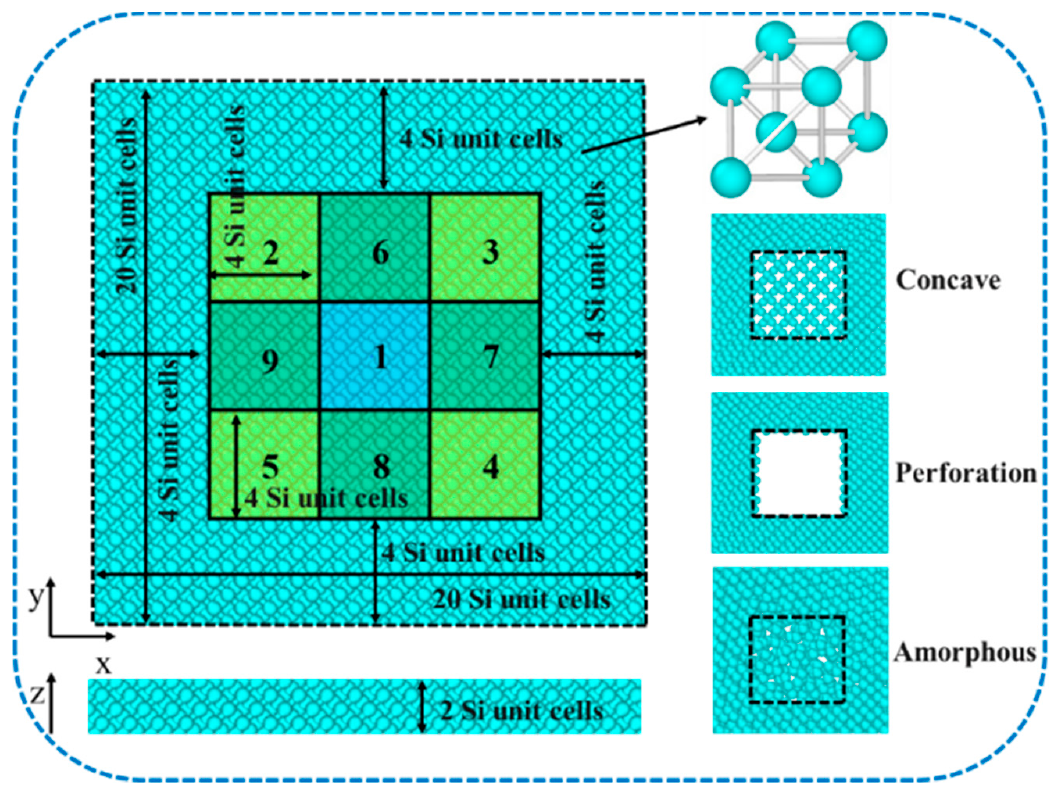
Figure 1. Schematic diagram of the calculation model.